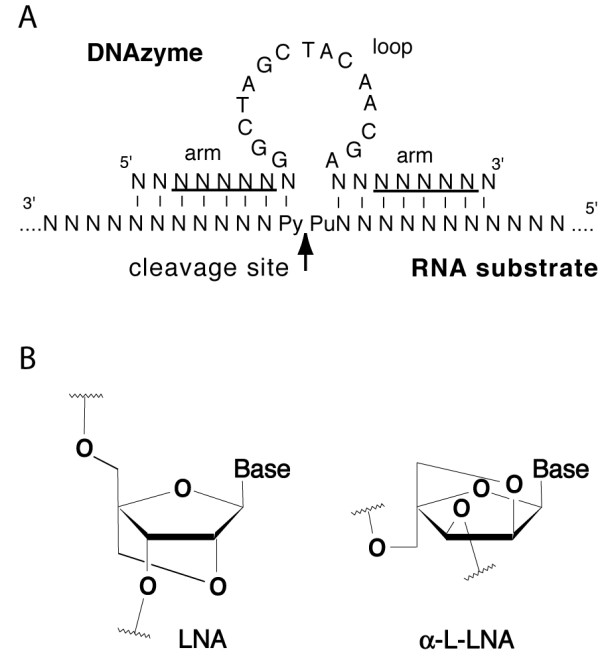
A. Schematic of a 10–23 DNAzyme hybridized via Watson-Crick base-pairing to an RNA substrate. The underlined sequence indicates the region where the LNA-type monomers were introduced (Table 1). Pu, purine; Py, pyrimidine. B. Structures of LNA (locked nucleic acid) and α-L-LNA nucleoside monomers.